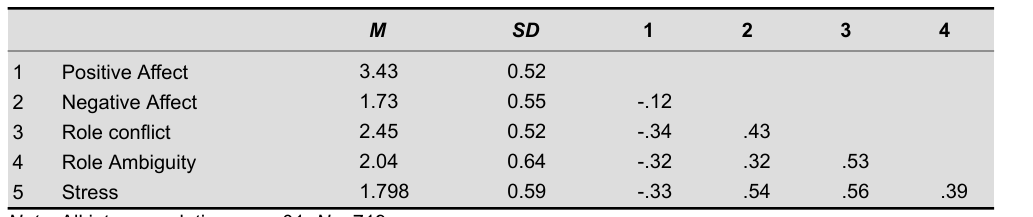
Inter-Correlations (Pearson’s rxy) for the Variables in the